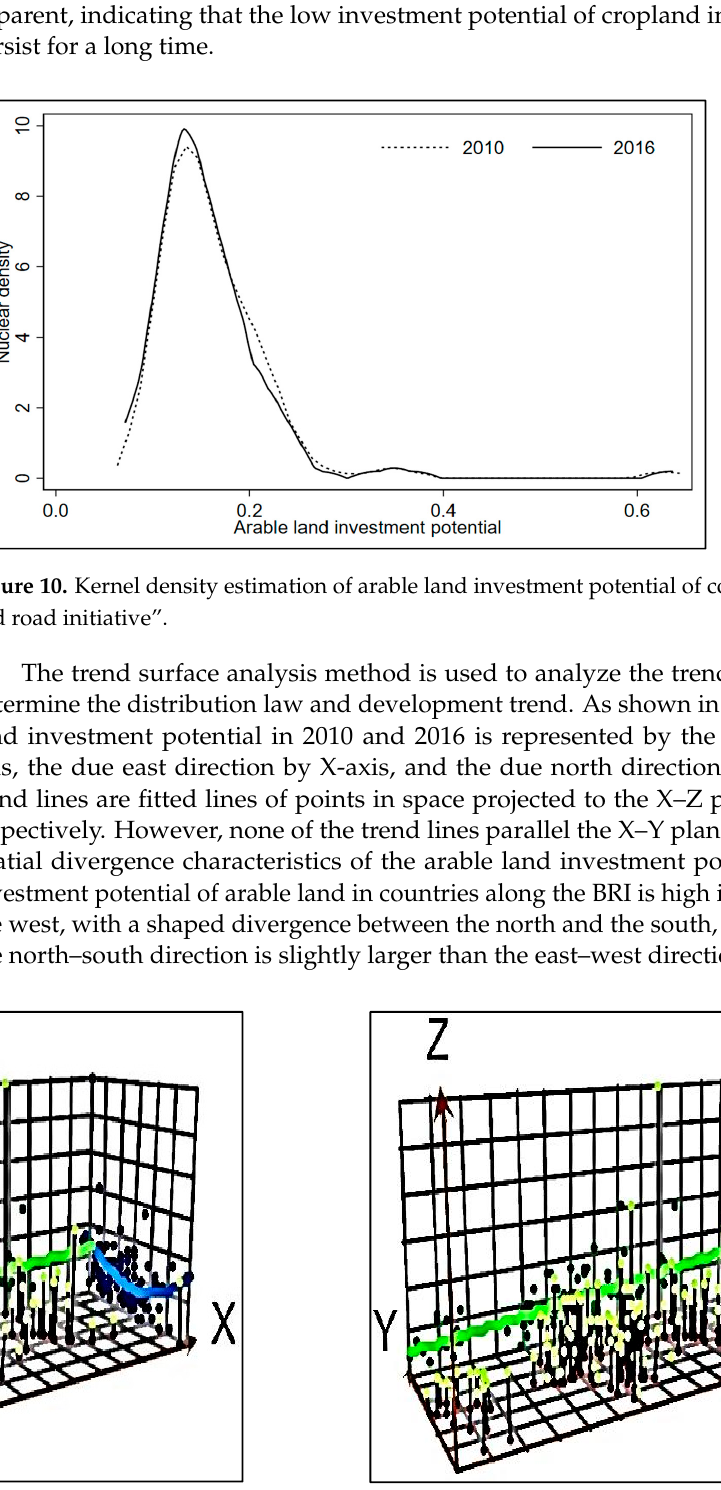
Figure 11. Trend surface analysis of arable land investment potential of countries along “the belt and road initiative”.